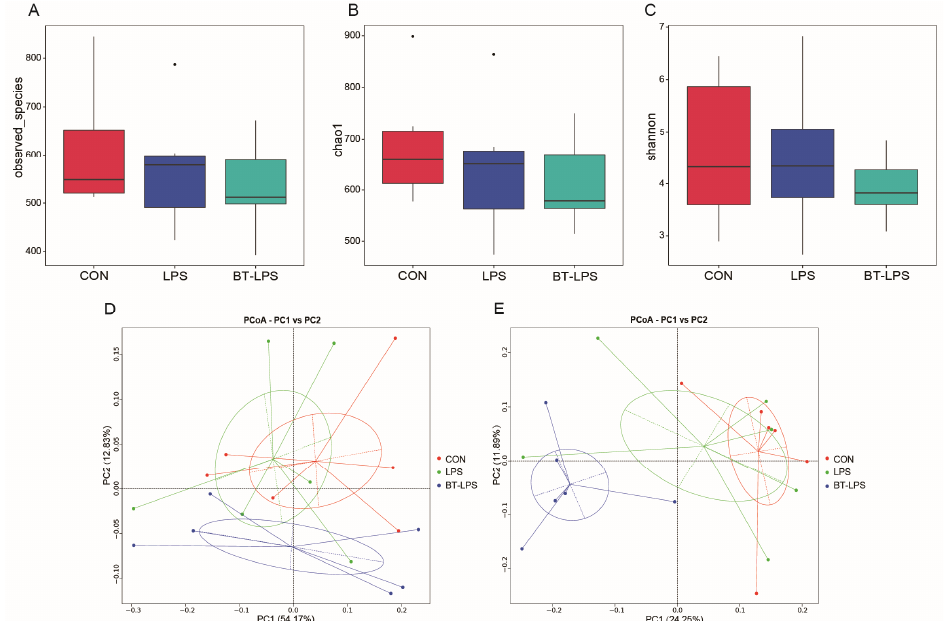
Figure 3. The effects of butyrate on microbiota diversity in LPS-induced jejunum. ( A – C ) Bacterial richness and diversity were estimated using Observed_species, Chao 1 value, and Shannon indices; “.” represents outlier points. ( D , E ) Principal coordinate analysis based on weighted and unweighted Unifrac distance showed separations among groups. Values are the mean ± standard error ( n =